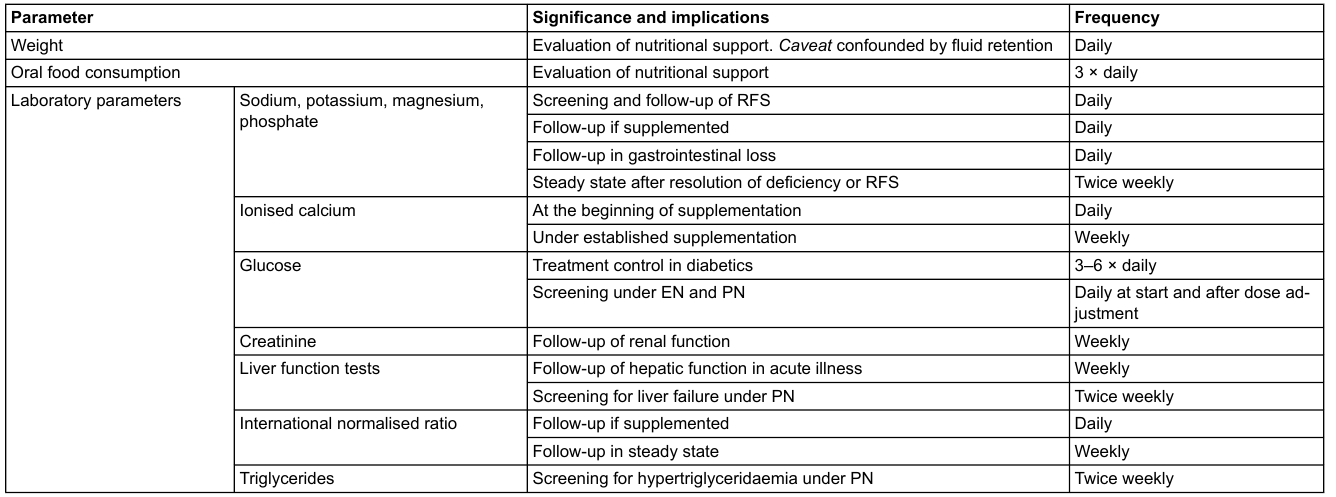
Table 2: Monitoring during nutritional therapy. Parameter Significance and implications Weight